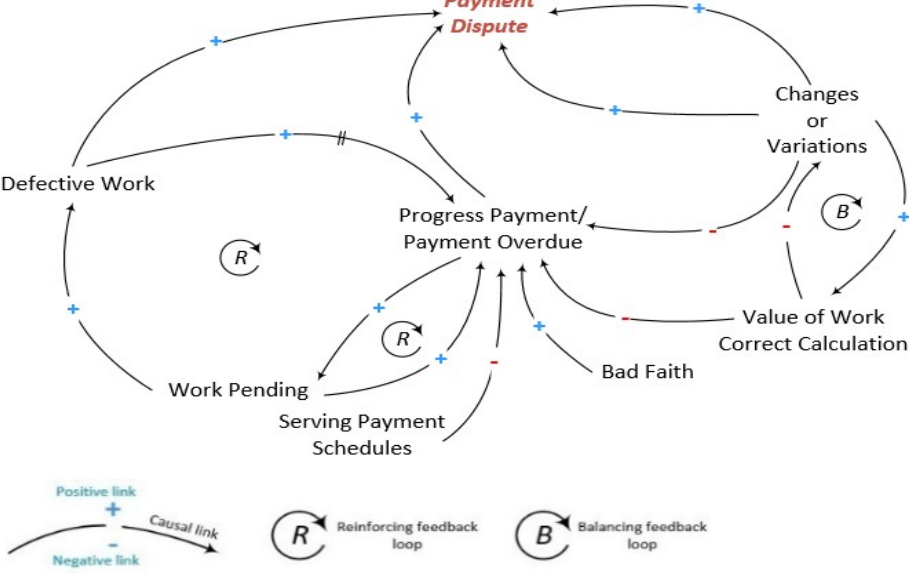
Figure 7. CLD for payment-related disputes.